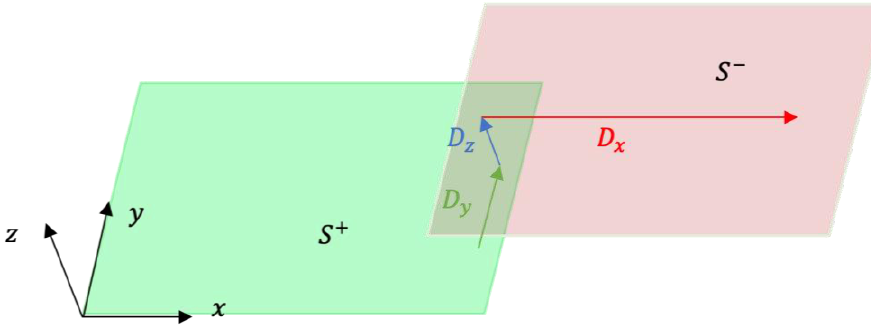
Figure 3. 3D rectangular DD element.